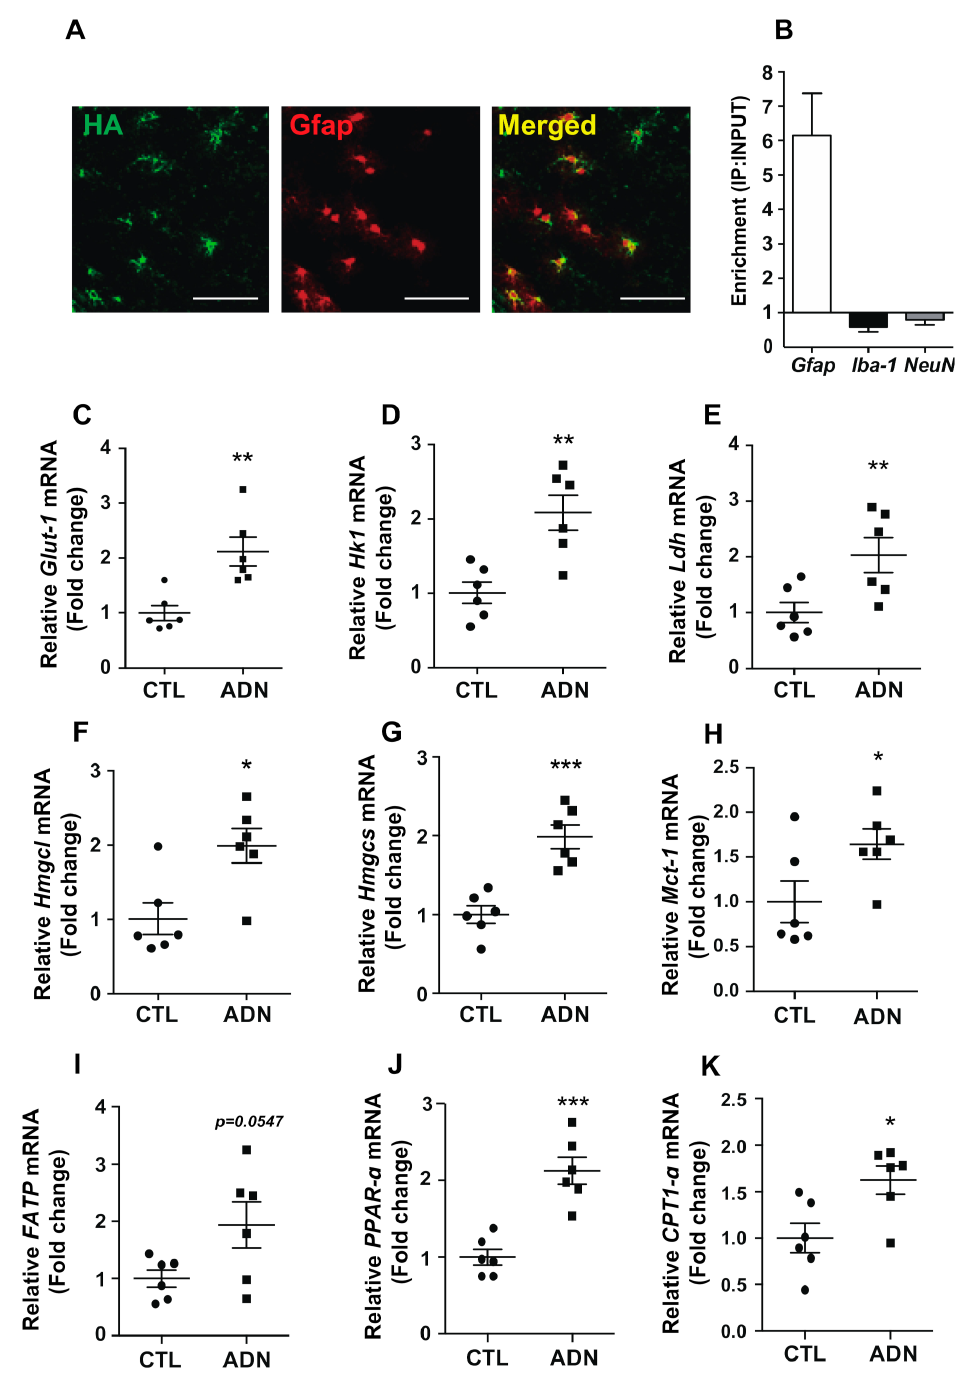
Figure 5. Central administration of adiponectin leads to enhanced glucose utilization and monocarboxylates production in hypothalamic astrocytes of the mice. Ribo-tag analysis were performed to determine alterations in astrocyte-specific mRNA expression in the hypothalamus of Gfap-CreER T2 :Rpl22 HA mice. ( A ) Representative images revealing co-expression of HA and Gfap immunosignals in the hypothalamus of Gfap-CreER T2 :Rpl22 HA mice. ( B ) qRT-PCR data showing enrichment of Gfap mRNA, a molecular marker for astrocyte (but not Iba-1 , a molecular maker for microglia and NeuN , a molecular marker for neuron) in the purified RNA immunoprecipitated with HA antibody compared with the input RNA extracted from hypothalamus. Elevated mRNA levels of ( C ) Glut-1, ( D ) Hk1, ( E ) Ldh, ( F ) Hmgcl , ( G ) Hmgcs , ( H ) Mct-1 , ( I ) FATP , ( J ) PPAR- α and ( K ) CTP1- α were observed in hypothalamic astrocytes from Gfap-CreER T2 :Rpl22 HA mice that received an icv injection of adiponectin (ADN, 3 µ g/2 µ L) compared with vehicle-treated control group (CTL). Results are presented as mean ± SEM. n = 6 for each group. * p < 0.05, ** p < 0.01, *** p < 0.001. Scale bar = 50 µ